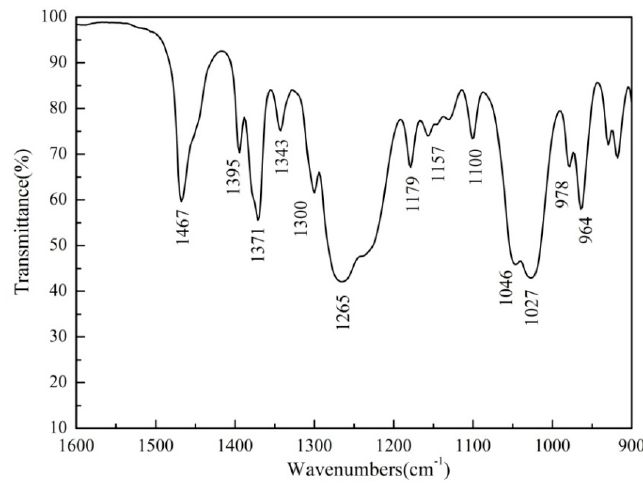
Figure 10. FTIR spectrum of dibutyl dixanthogen.